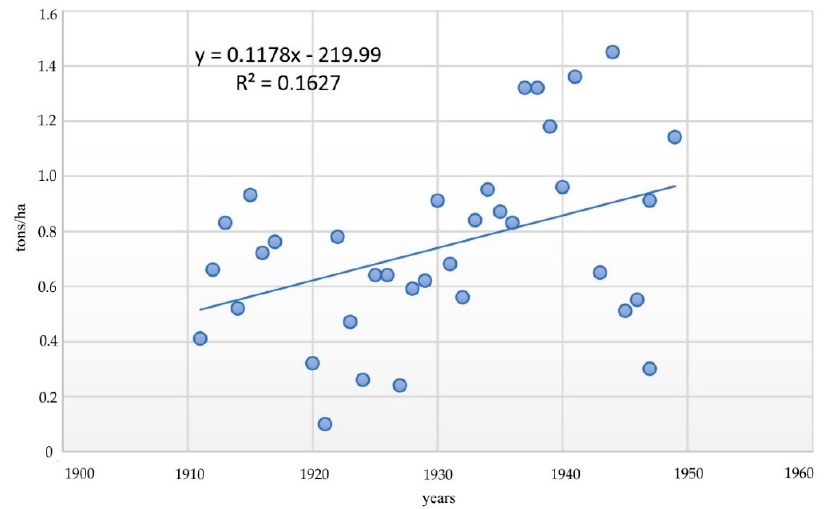
Figure 3. Winter wheat yields in 1910–1950, tons/ha. Source: authors’ development based on [118–